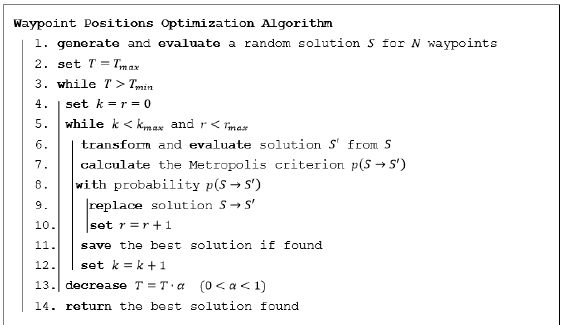
Figure 3. Simulated annealing used for the waypoint positions optimization problem.